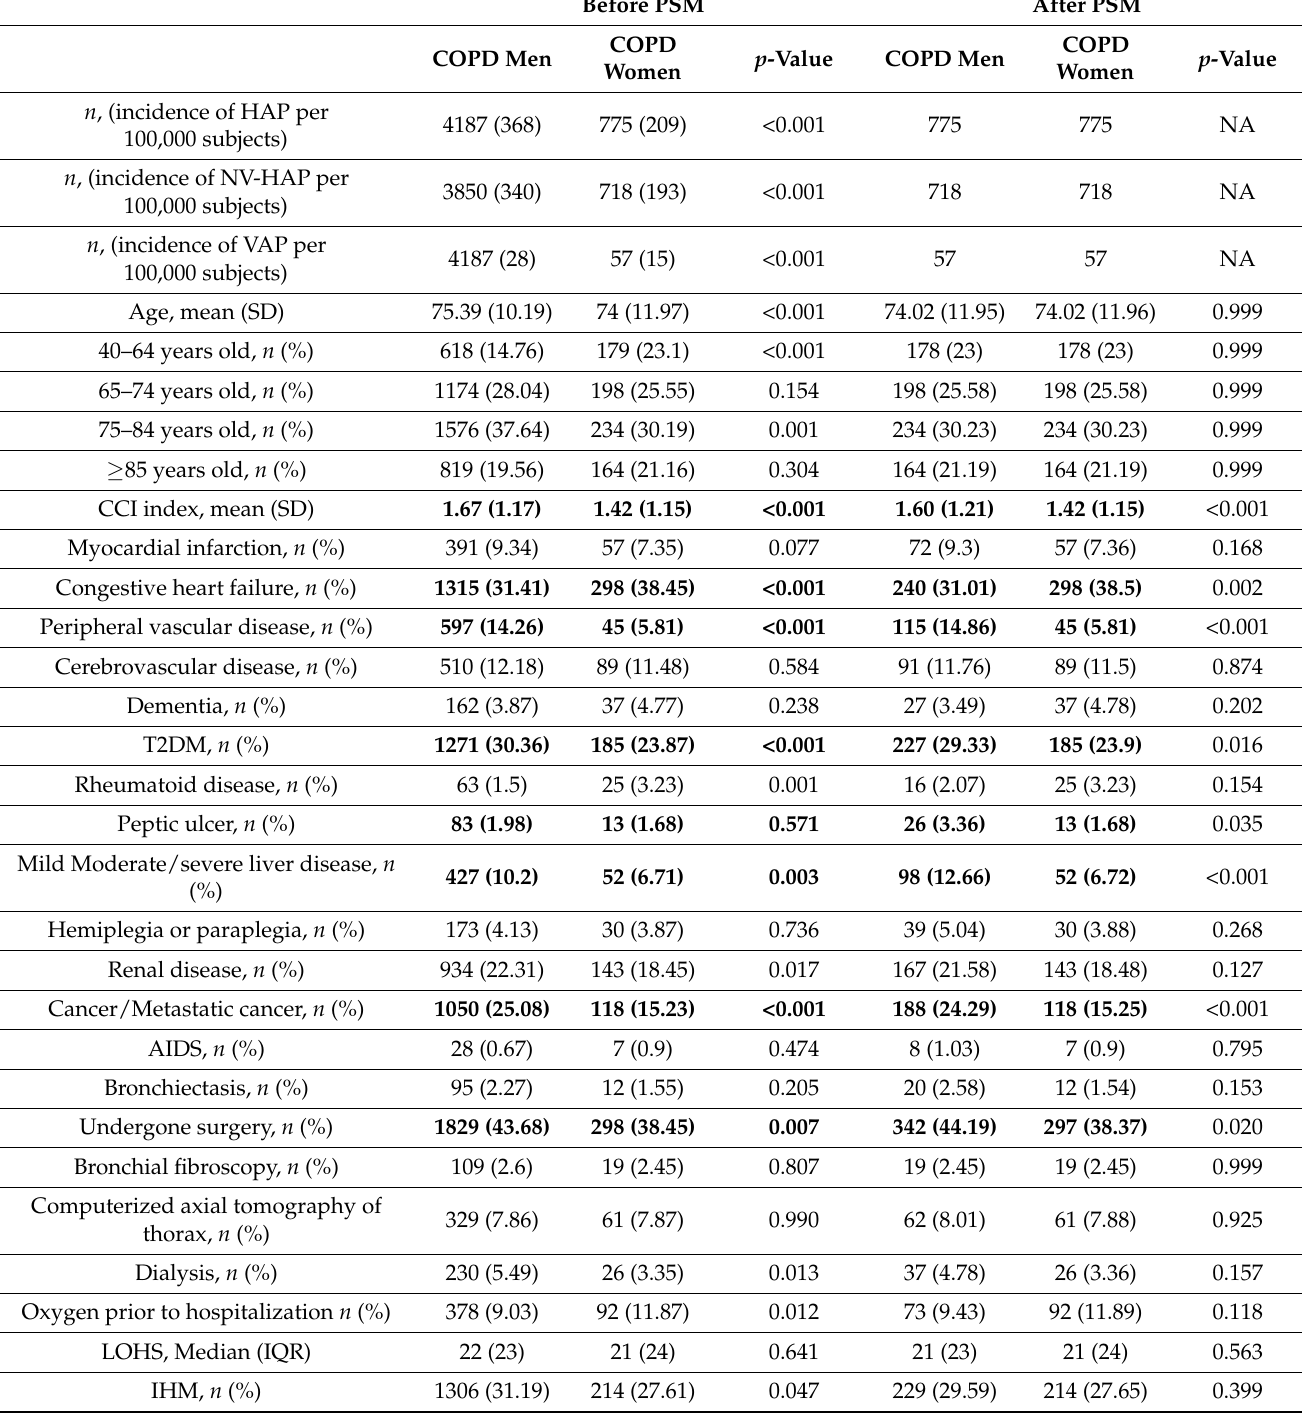
Table 4. Distribution of study covariates and hospital outcomes of MEN AND WOMEN with COPD hospitalized with hospital-acquired pneumonia (HAP) in Spain (2016–2019), before and after propensity score matching (PSM).